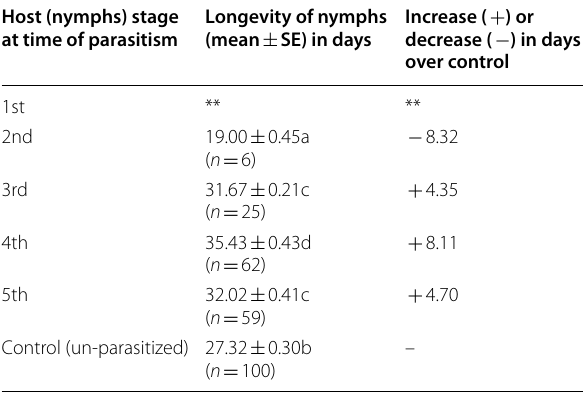
Table 1 Effect of parasitism by F. melanoleuca on the longevity of P. perpusilla